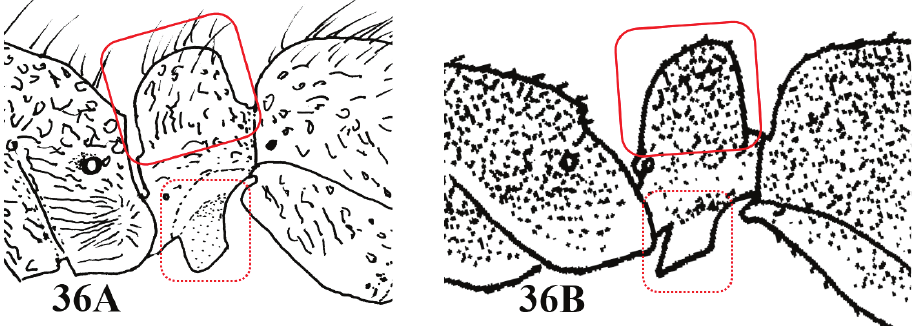
Figure 36. A G. quadrutinodules worker B G. coccina worker (Cited from Zhou,